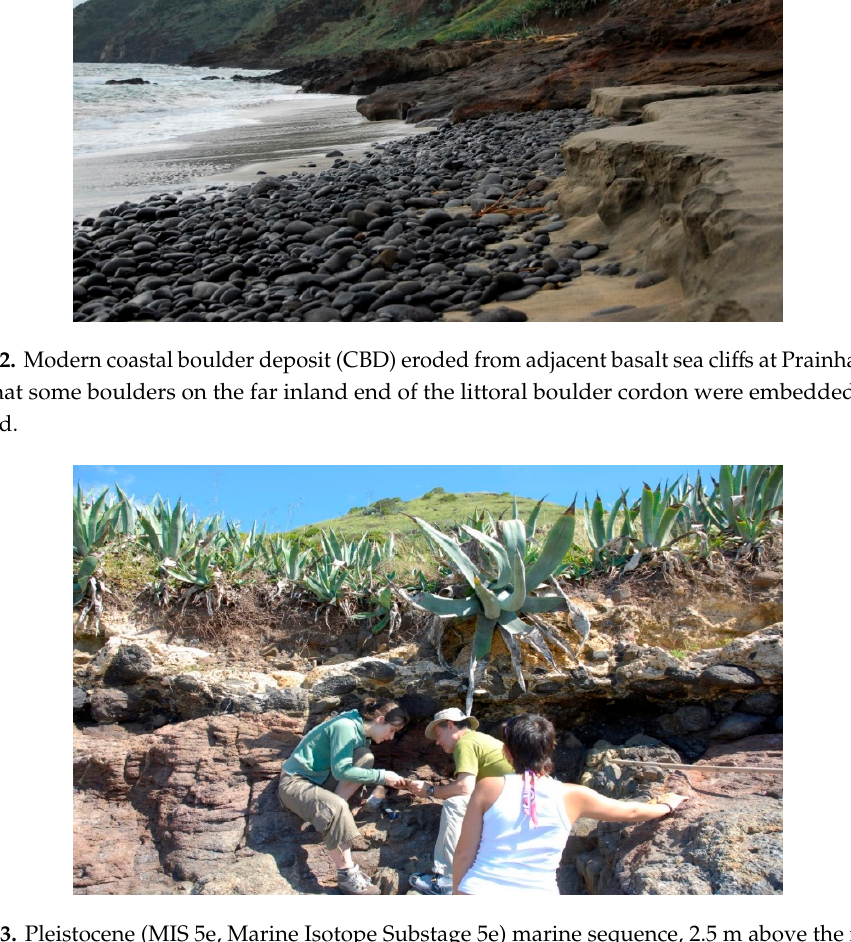
Figure 3. Pleistocene (MIS 5e, Marine Isotope Substage 5e) marine sequence, 2.5 m above the modern CBD at Prainha (site 2). Note that, as modern CBD, Pleistocene boulders were covered by Pleistocene fossiliferous sands.